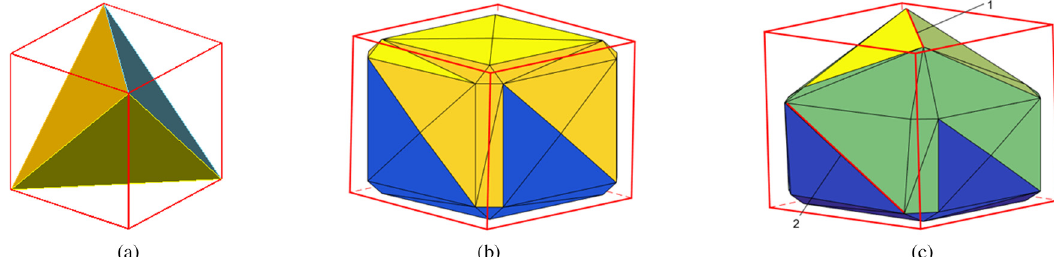
ffiffiffi p 2 circumscribed by minimal box with edge